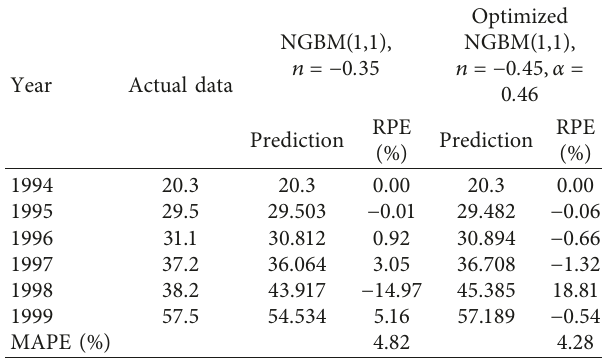
Figure 1: The track of simultaneously seeking the parameters n and α in the optoelectronic components. Table 2: Results of optoelectronic components from the two models.